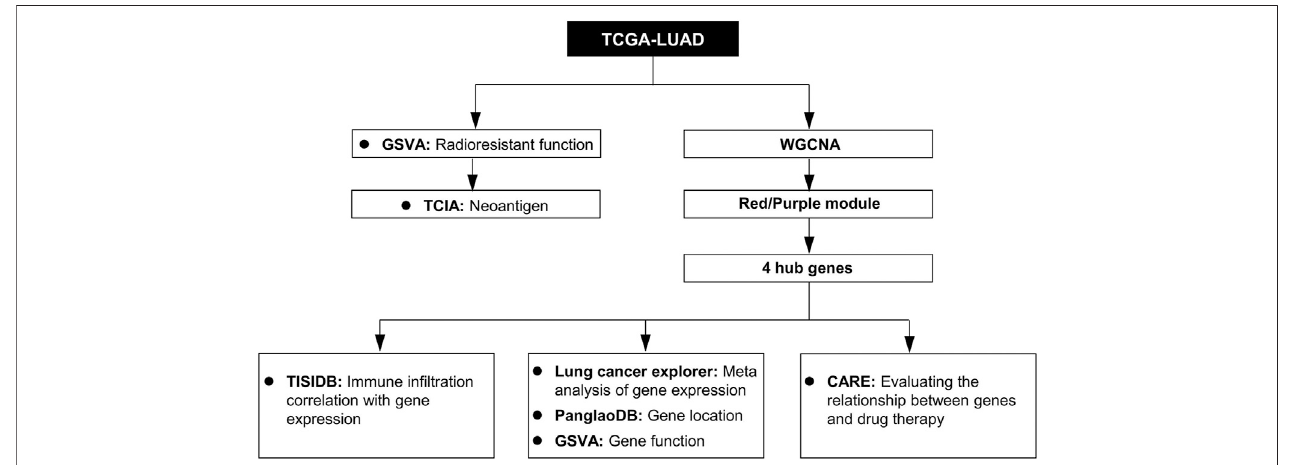
FIGURE 1 | Study work fl ow. TCGA-LUAD, The Cancer Genome Atlas LUAD datasets; GSVA, gene set variation analysis; WGCNA, weighted gene co-expression network analysis; TCIA, The Cancer Immunome Database; TISIDB, Tumor and Immune System Interaction Database; PanglaoDB, single-cell RNA sequencing experiments from mouse and human database; CARE, Computational Analysis of